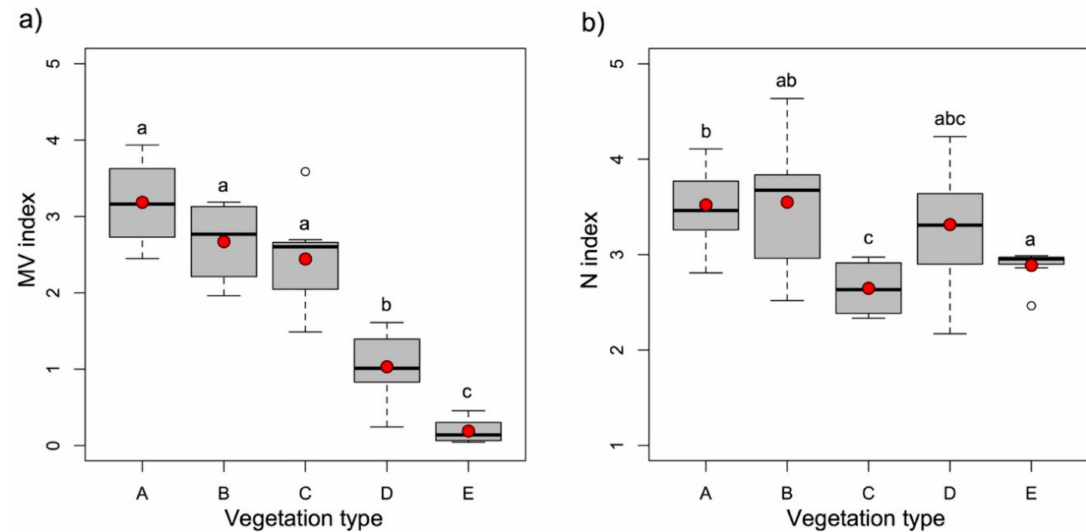
Figure 4. Boxplots of the distribution of mowing tolerance index (MV) ( a ) and index of nutrients (N) ( b ) for each vegetation type (A, meadows; B, meadows-pastures; C, pastures; D, shrublands; E, forests). For each boxplot, mean (red dot) and median (black line) are highlighted. Di ff erent letters above the boxes indicate significant di ff erences ( p < 0.01) among vegetation types: A, meadows; B, meadows-pastures; C, pastures; D, shrublands; E,